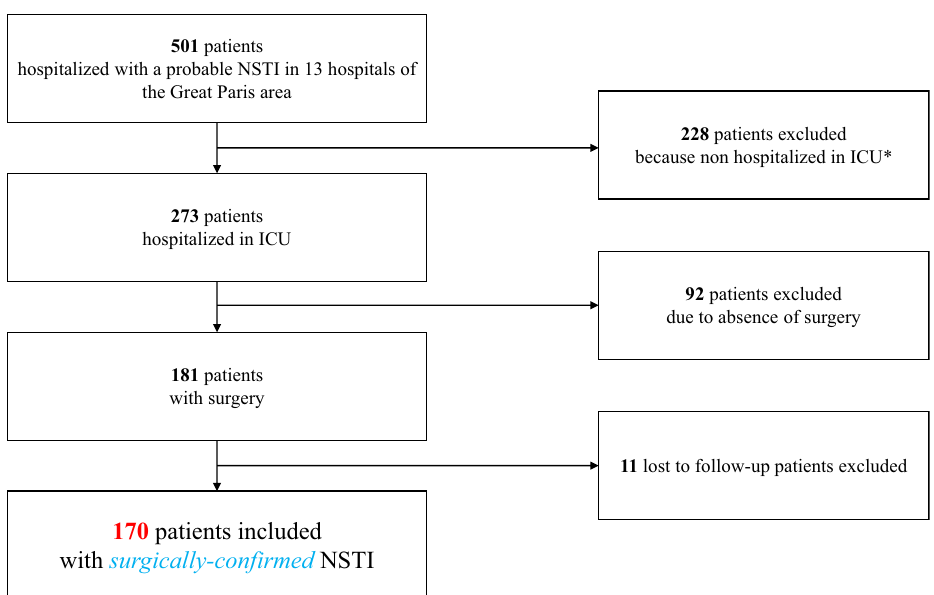
Fig. 1 Study flowchart. NSTI necrotizing soft tissue infection; ICU intensive care unit; *These patients were men in 61.5% of cases, had a median age of 64 years (49–77) and an 11.8% in‑hospital mortality (data available for 187/228